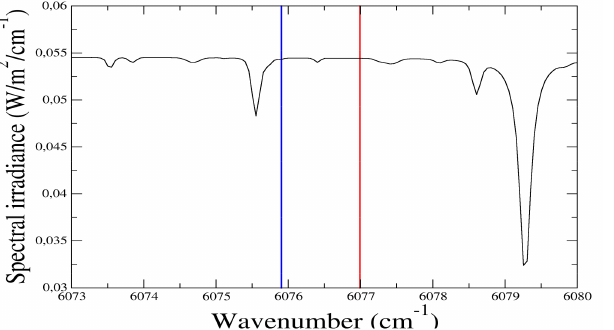
Figure 13. Solar spectrum over the width of the MERLIN spectral filter. The red (resp. blue) line indicates the wavelength of the laser beam On (resp.